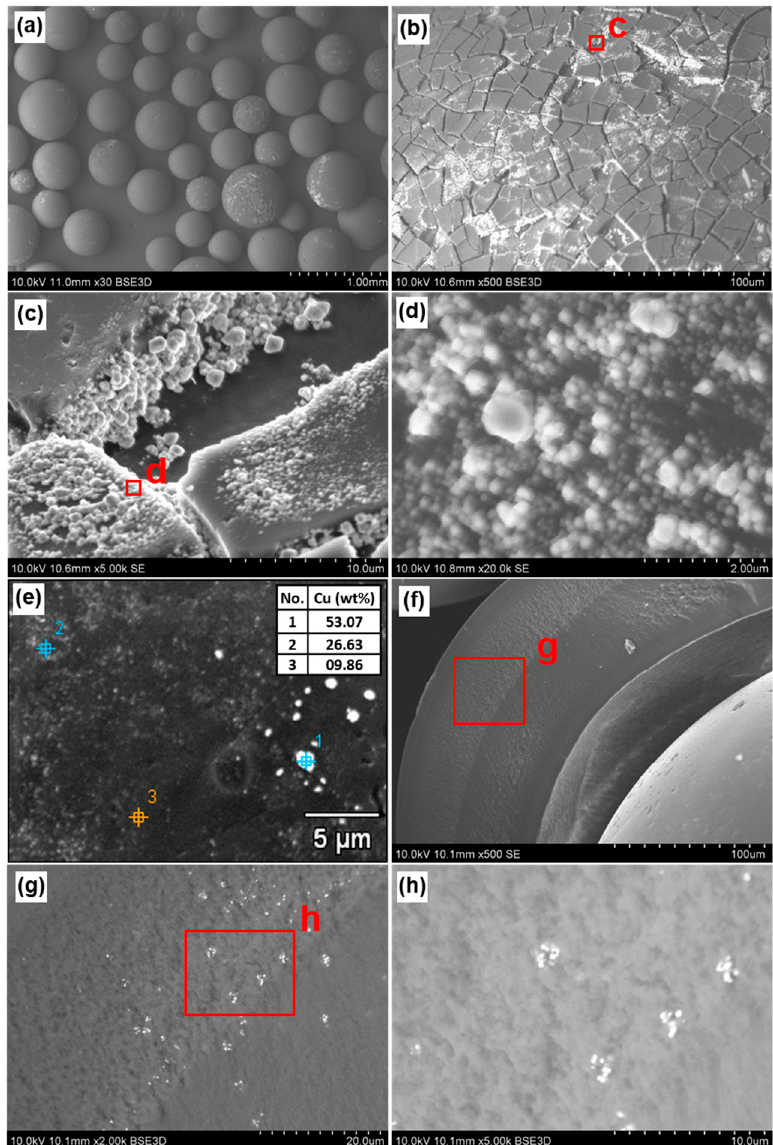
Figure 9. SEM images and EDS analysis of the G/An/Cu-2 ( a )–( e ) surface, ( f )–( h ) inside.